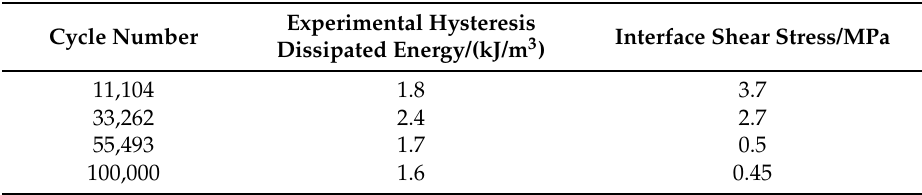
Table 4. The interface shear stress of 2D woven C/SiC composite corresponding to different applied cycles under fatigue peak stress of σ max = 57 MPa at room